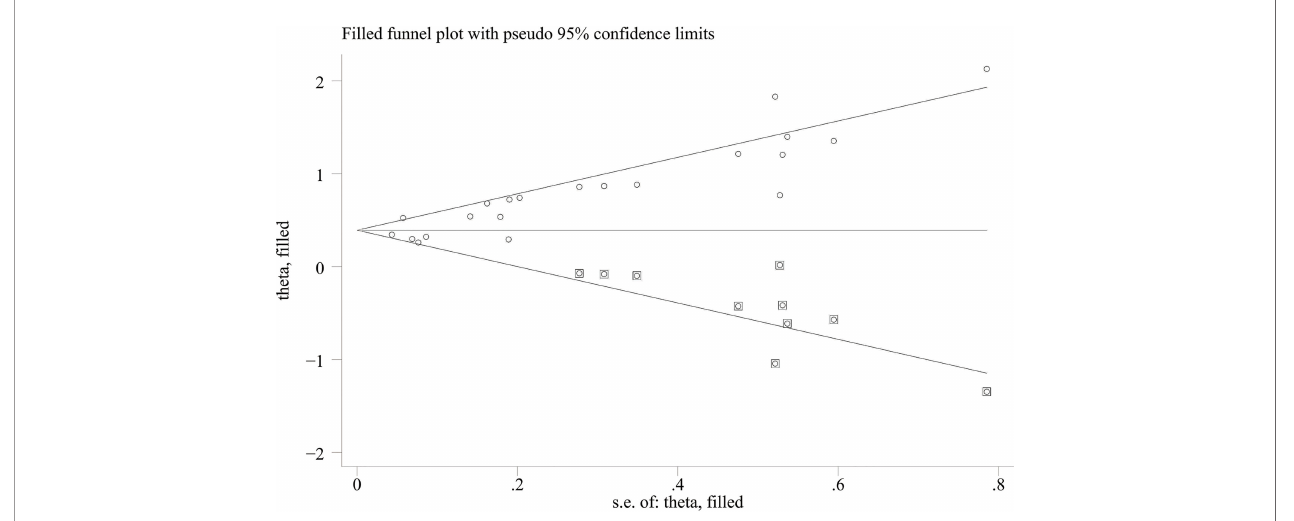
FIGURE 3 | Trimming chart of univariate analysis outcomes of baseline CRP levels and OS [round dots = the observed studies, square dots = the missing studies imputed by the trim – and – fi ll method, solid lines that create a triangular area indicate the 95% CI (under the fi xed – effect model), and the horizontal solid line represents the overall effect size.